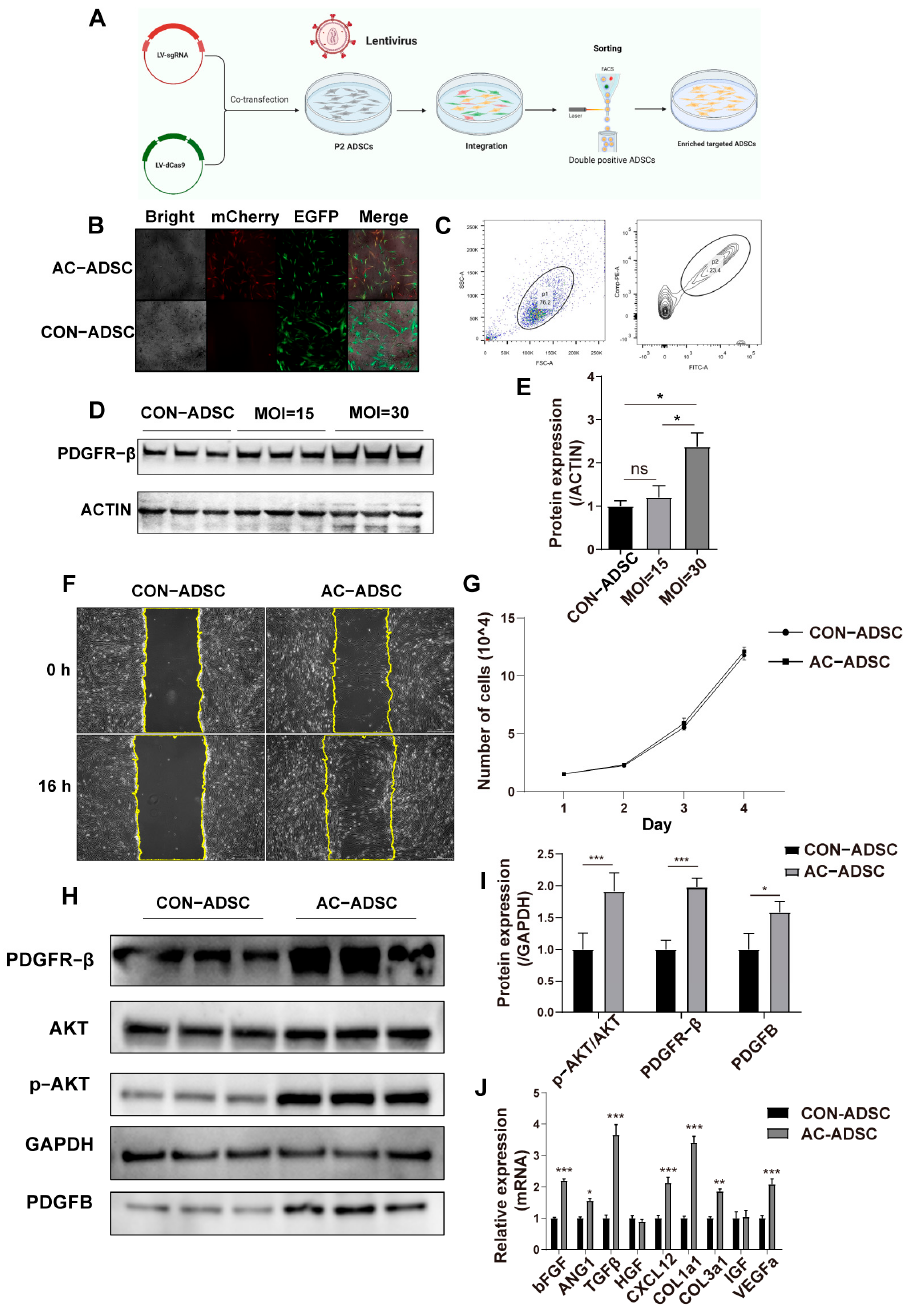
Figure 2. Endogenously activated PDGFR −β in ADSCs through SAM system. ( A ) Two-lentivirus system coinfection and sorting process. ( B ) Representative single-channel and overlay images of mCherry + and GFP + ADSCs. ( C ) Sorting of mCherry and GFP double positive ADSCs. ( D ) PDGFR −β expression and ( E ) levels relative to ACTIN in ADSCs with different multiplicity of infection ( n = 3). ( F ) In vitro migration of CON − ADSCs and AC − ADSCs determined by scratch test. ( n = 6, scale bar = 200 μ m). ( G ) Growth curve of AC − ADSC and CON − ADSC ( n = 3). ( H , I ) Western blotting analysis of the levels of PDGFR −β , PDGFB, p − AKT in CON − ADSCs and AC − ADSCs ( n = 3). ( J ) Expression of some growth factors and cytokines detected by RT − qPCR ( n = 3). Data are shown as mean ± SD. Independent-sample t test (two-tailed) was used for statistical comparisons between 2 groups; One − way ANOVA followed by Tukey post hoc test was used for statistical comparisons between multiple groups. * p < 0.05; * * p < 0.01; ** * p < 0.001.